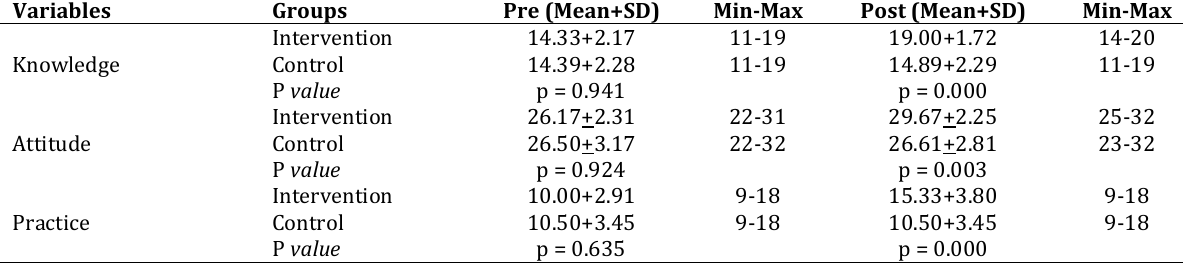
Table 1. Data on Knowledge, Attitude, and the Practice of Salat (Spiritually) Variables